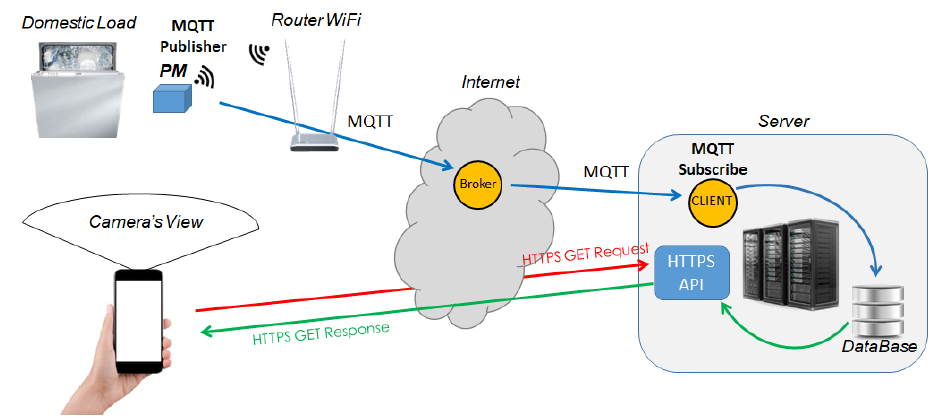
Figure 11. Proposed approach for power consumption awareness based on Augmented